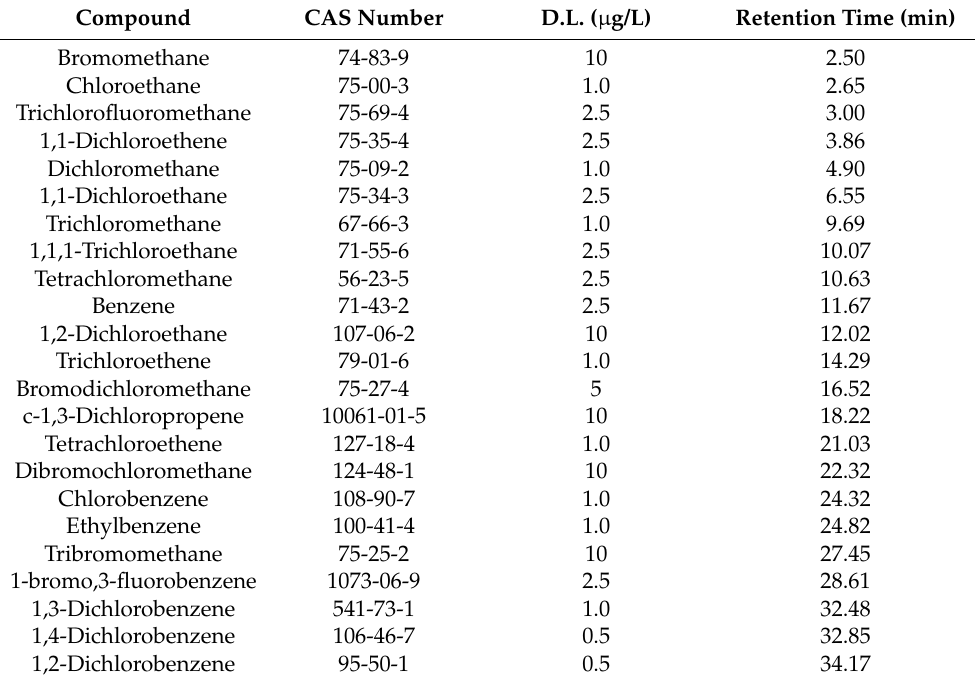
Table 1. Halogenated compounds: detection limits (D.L.) and retention